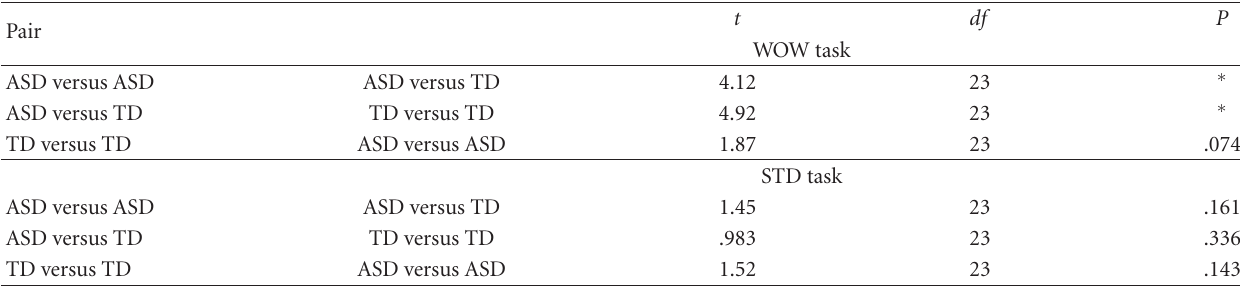
Table 2: Planned comparisons of mean alignment scores between di ff erent types of match within each task. Pair